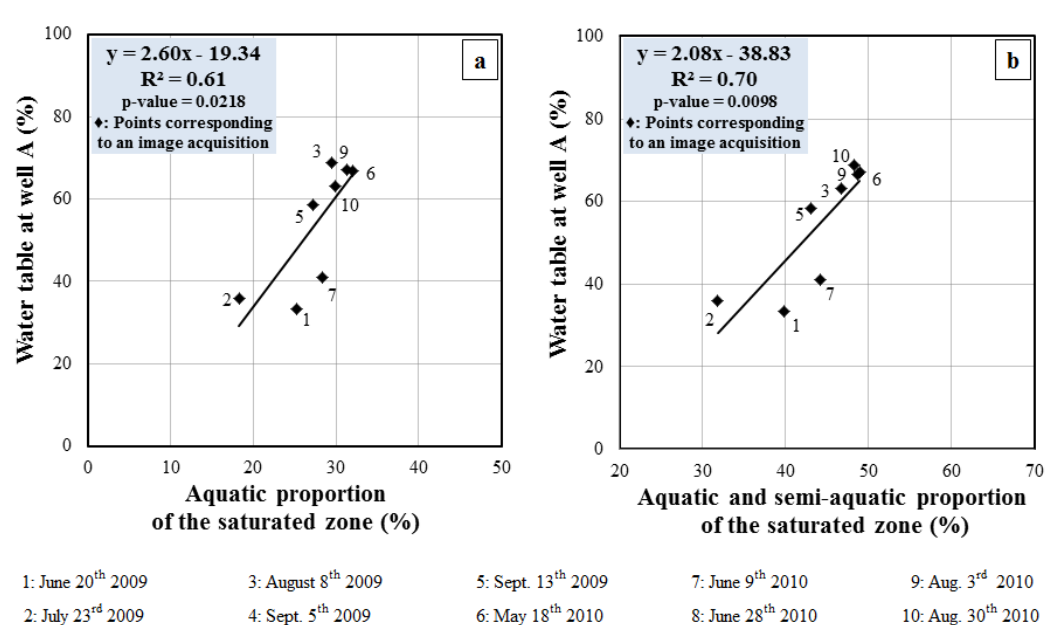
Figure 12. ( a ) Water table measured at well A compared to corresponding aquatic proportion of the site 1 saturated zone (derived from GeoEye-1 image classifications). ( b ) Water table measured at well A compared to corresponding aquatic and semi-aquatic proportion of the site 1 saturated zone. The range of measured water table values is displayed in percentages, 100% corresponding to the maximal water table value (0% to the